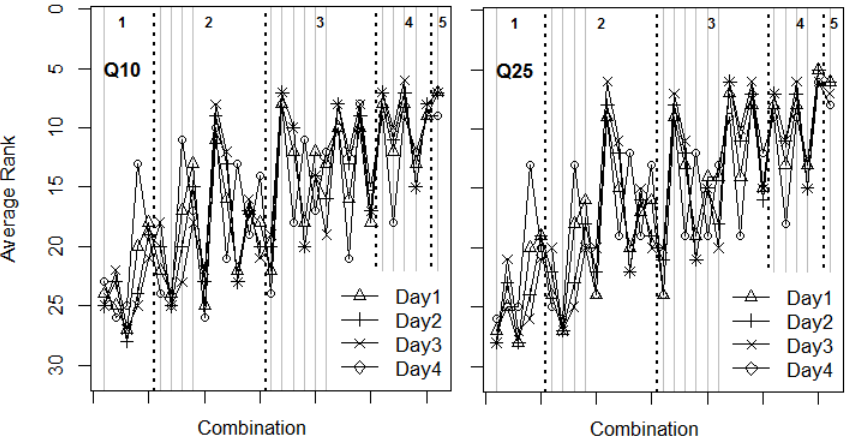
Figure 7. Average rank for each joint predictor for 1–4 days of lead time and two percentiles of observed water levels. Vertical gray lines correspond to the configurations that include the forecast as one of the predictors. The y axis is reversed so that an increasing trend indicates increasing performance.